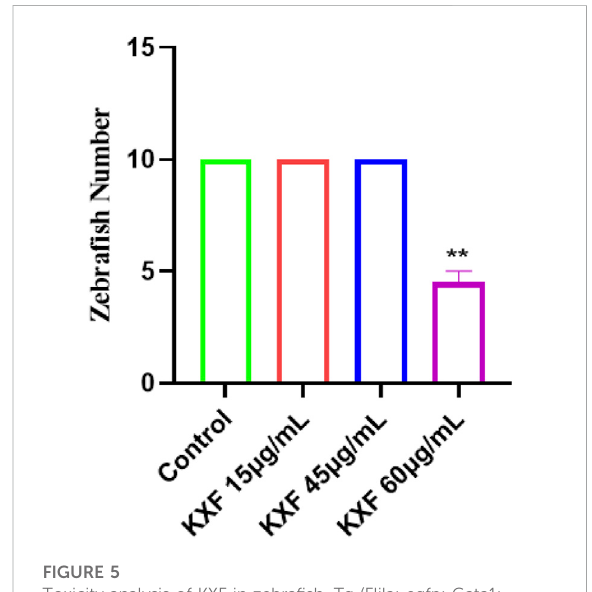
FIGURE 5 Toxicity analysis of KXF in zebra fi sh. Tg (Flila: egfp; Gata1: dsred) transgenic zebra fi sh of 48hpf was treated with different dosages of KXF for 48 h to determine the safe dosage of KXF.